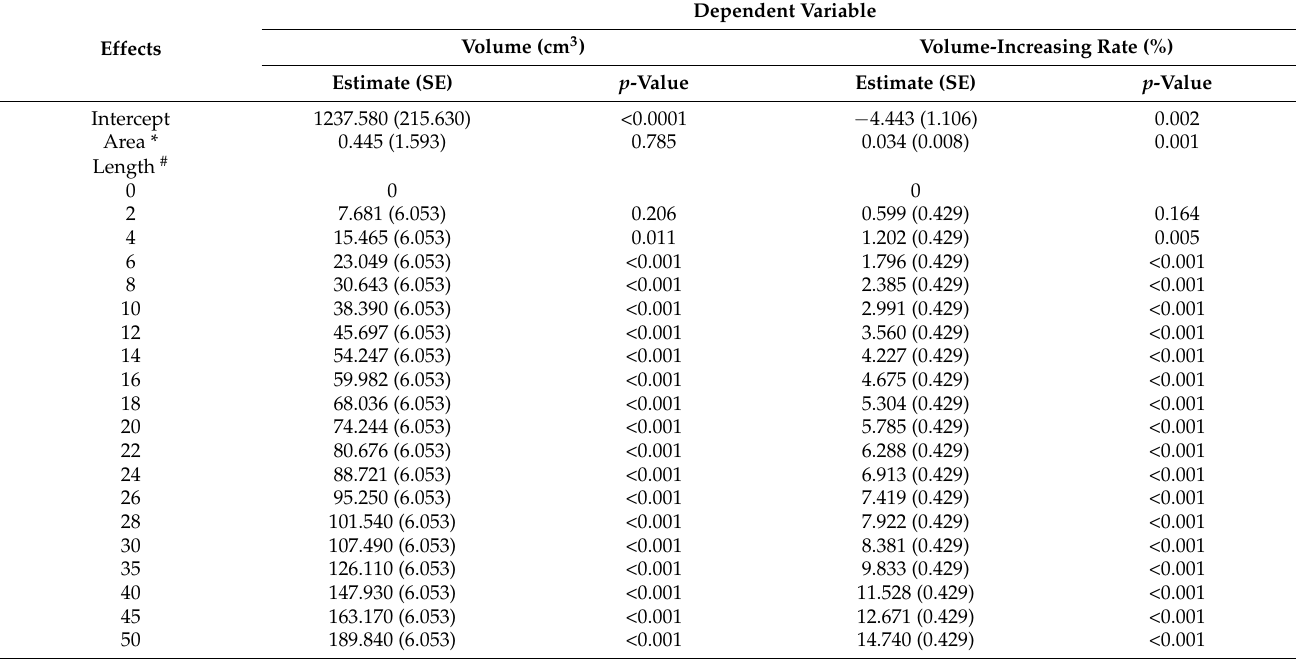
Standard error: SE; # length of contour elevation (length) (mm); * areas of skull defects (area) (cm 2